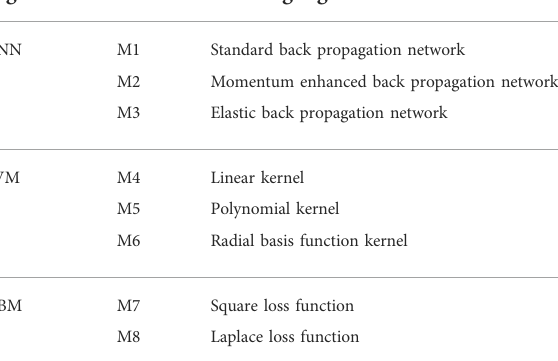
TABLE 1 Model pool.